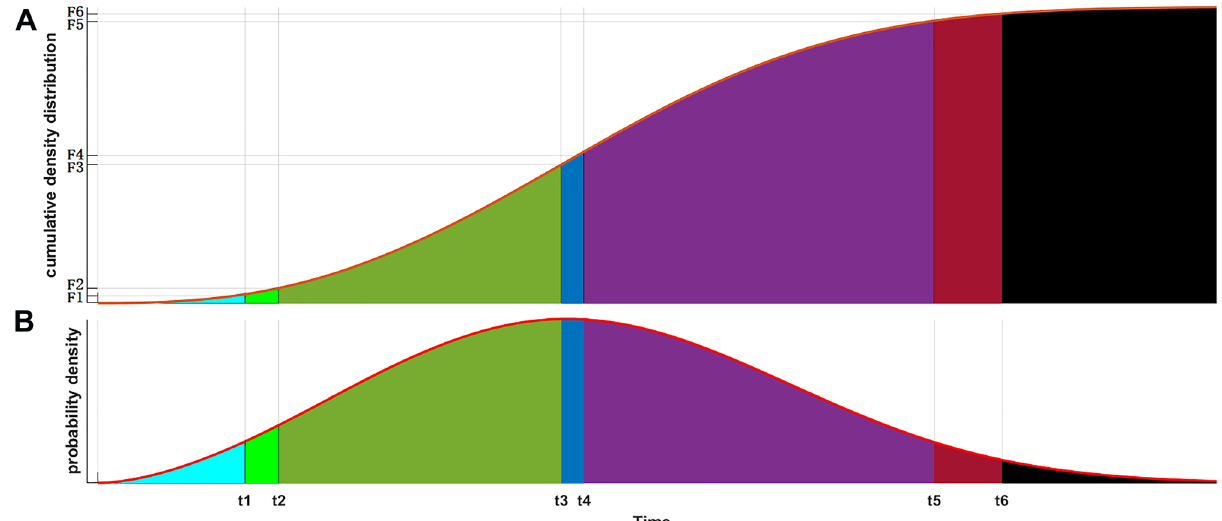
Figure 1. Calculation results of important time nodes. ( A ) Cumulative distribution function distribution. The abscissa is time. F1 = 2.5%, F2 = 5%, F4 = 50%, F5 = 95%, F6 = 97.5% and F3 is the F.peak, which can be calculated by Figure B. ( B ) Probability density function distribution, in which t1 = T.lower 97.5% CI, t2 = T.lower 95% CI, t3 = T.peak, t4 = T.median, t5 = T.upper 95% CI and t6 = T.upper 97.5%